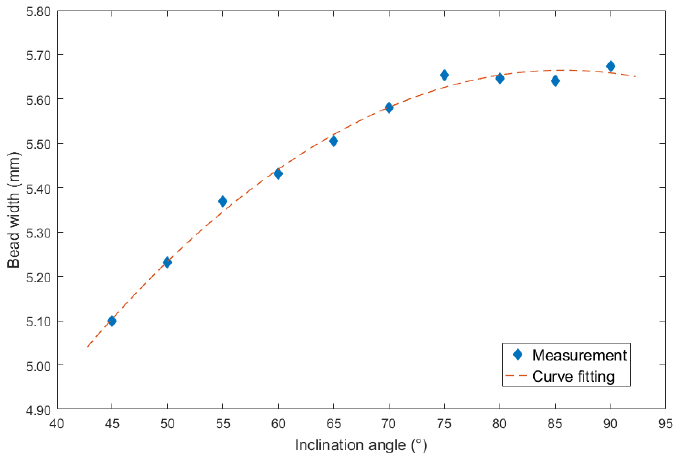
Figure 8. Curve fitting between backward inclination angle and bead width.